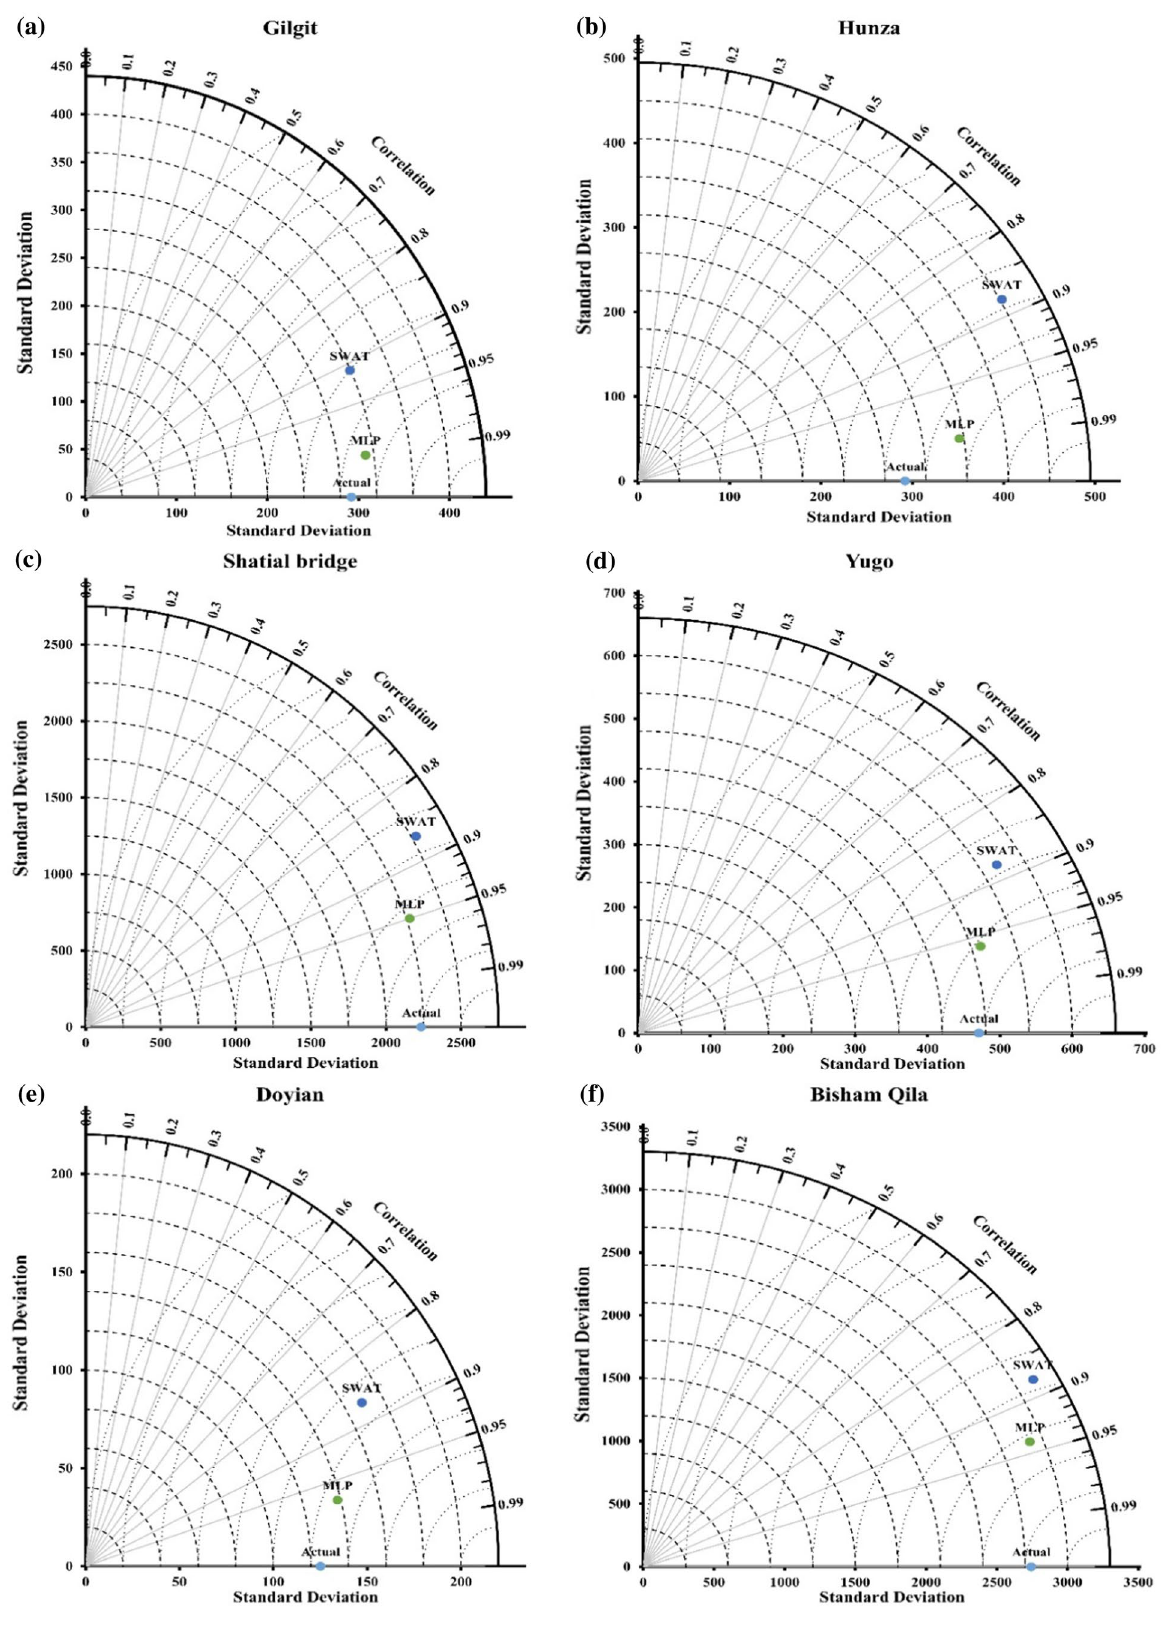
Fig. 6 Performance comparison of SWAT and MLP models with Tylor diagram across all